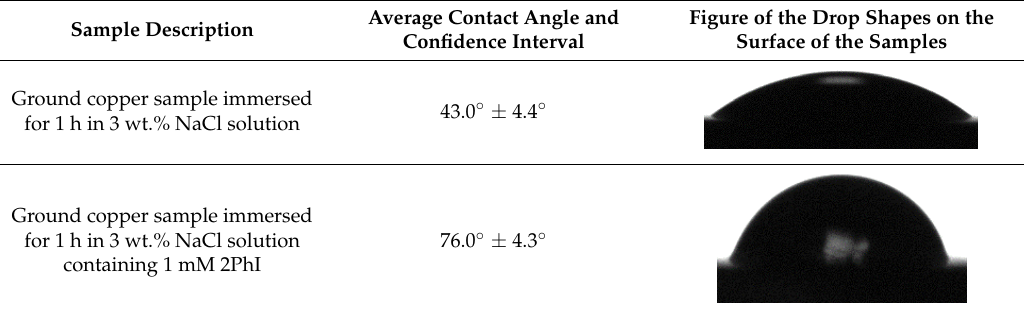
Figure of the Drop Shapes on the Surface of the Samples